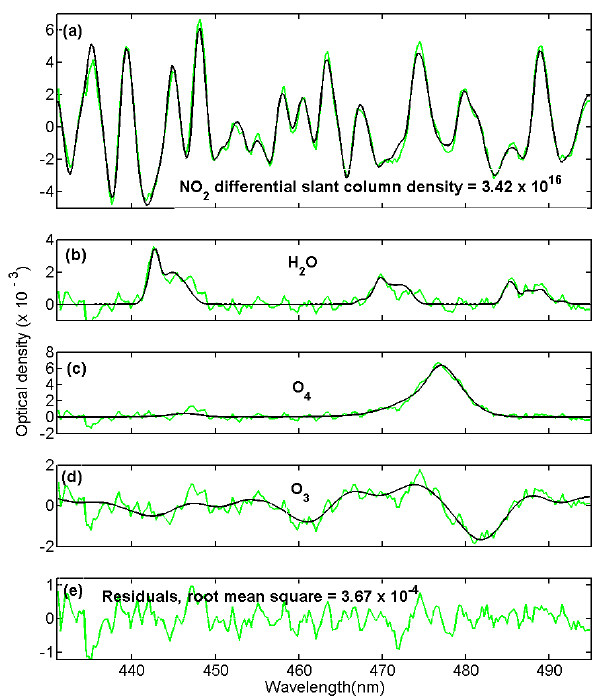
Fig. 5. Example of a DOAS fit; the spectrum was recorded in the Po Valley. Black lines correspond to molecular cross-sections scaled to the detected absorptions in the measured spectrum (green